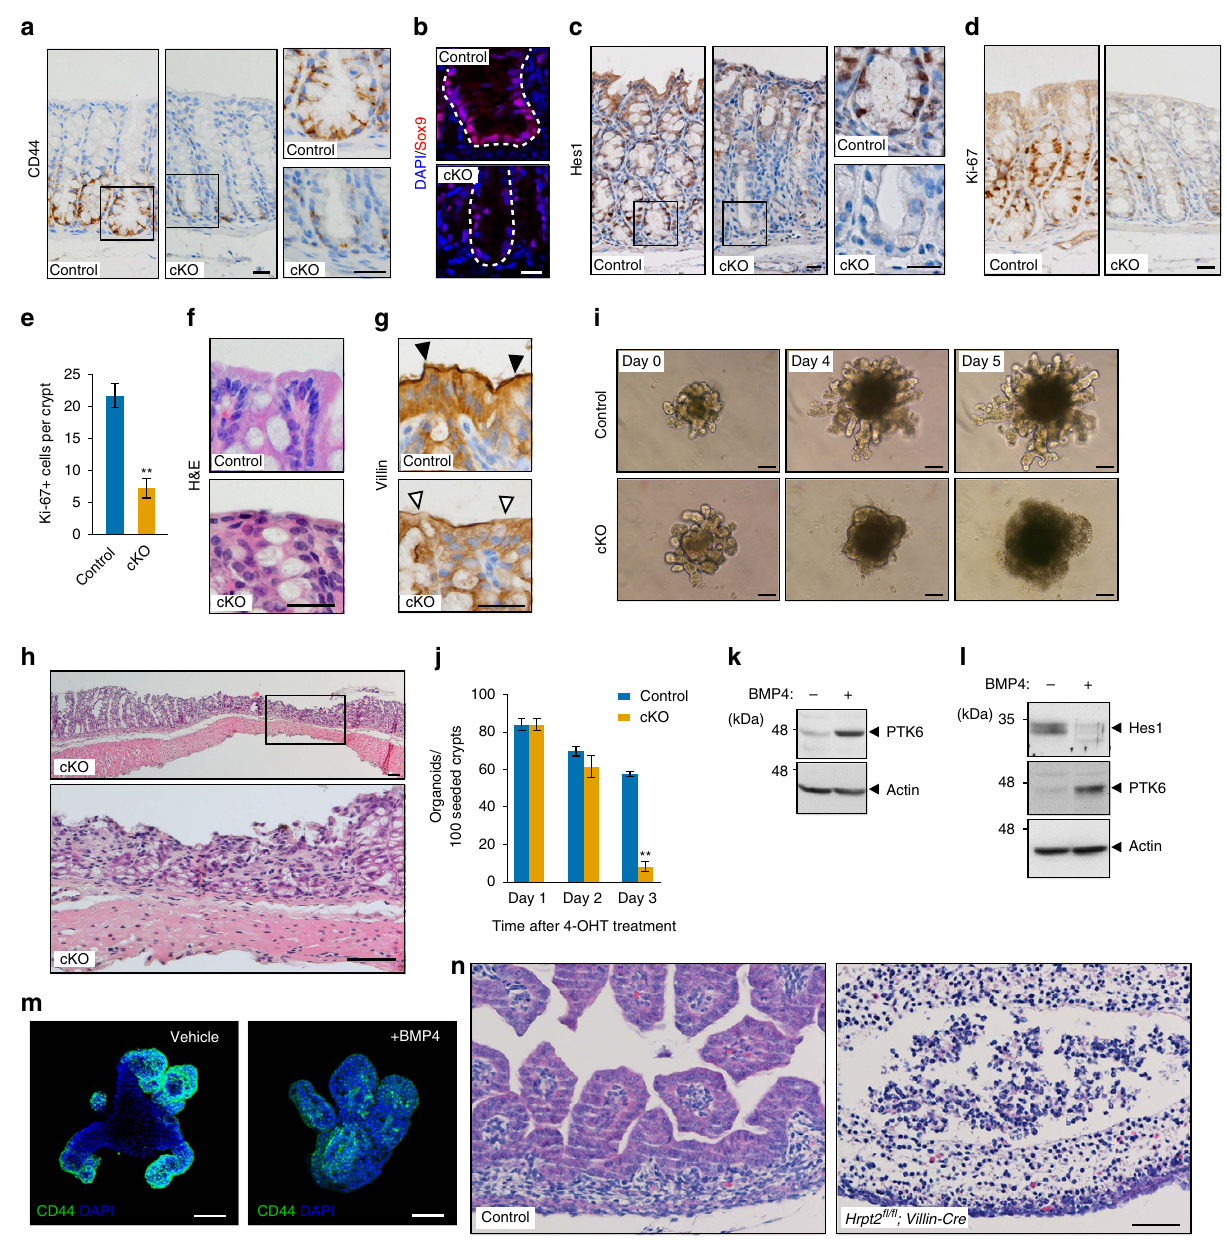
Figure 7 | Loss of parafibromin leads to disorganization of the intestinal epithelium. ( a – c ) Conditional knockout (cKO) of parafibromin results in decreased expression of Wnt and Notch targets in the intestine. CD44 immunohistochemistry ( a ), Sox9 immunofluorescent staining ( b ) and Hes1 immunohistochemistry ( c ) of control and parafibromin cKO colons. The right panels show higher-magnification images. Scale bars, 20 m m. ( d , e ) Parafibromin is essential for the intestinal epithelial cell proliferation. Ki-67 immunohistochemistry ( d ) and number of Ki-67-positive cells per crypt